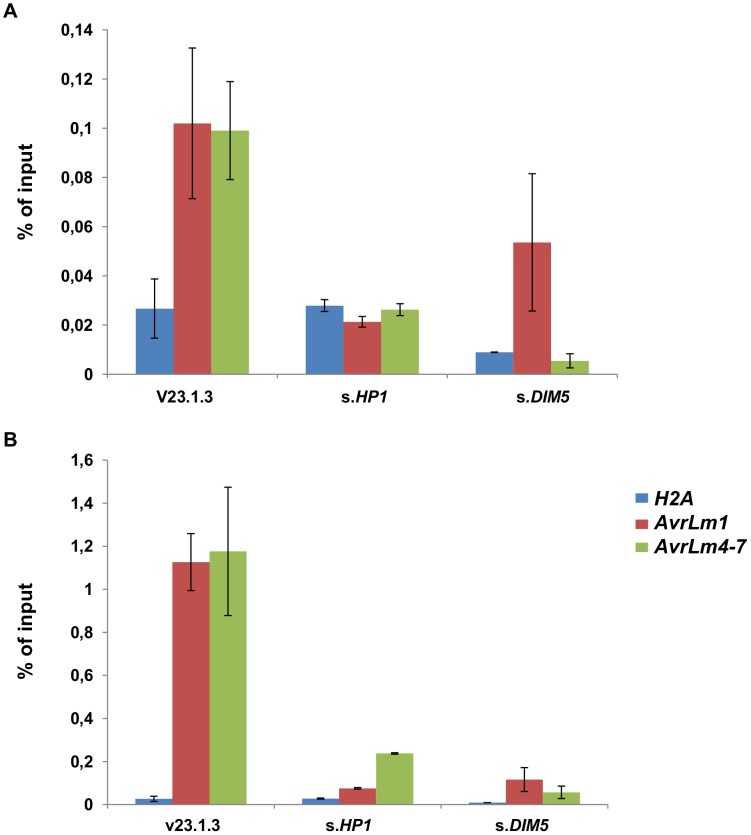
Trimethylation of lysine 9 of histone H3 (H3K9me3) is reduced in silenced-LmHP1 and silenced-LmDIM5 backgrounds.Chromatin immunoprecipitation analysis was performed to assess changes in the heterochromatic H3K9me3 mark in (A) the coding regions or (B) the promoters of AvrLm1 and AvrLm4-7. We used portions of the histone H2A gene as a negative control of H3K9me3 enrichment. Data were normalised using the “percent of input” method. AvrLm1_Pro and AvrLm4-7_Pro: promoter regions of AvrLm1 or AvrLm4-7. Error bars indicate the standard deviation of two biological and technical repeats.